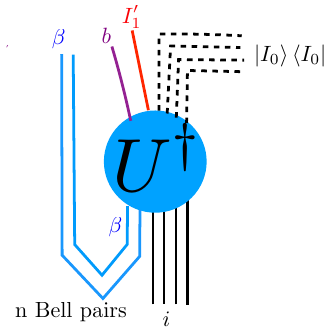
Figure 6 . Implementing ˜ U † with post